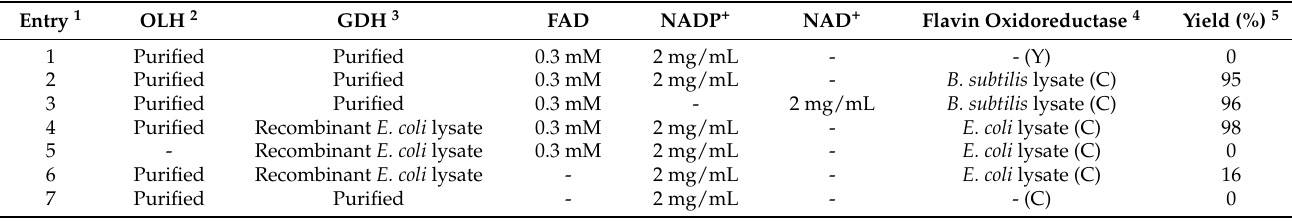
Figure 2. The enzyme-catalyzed reduction of FAD to FADH 2 . Table 2. Oleate hydratase catalyzed hydration of oleic acid in presence of enzymatically generated NADH, NADPH, and FADH 2